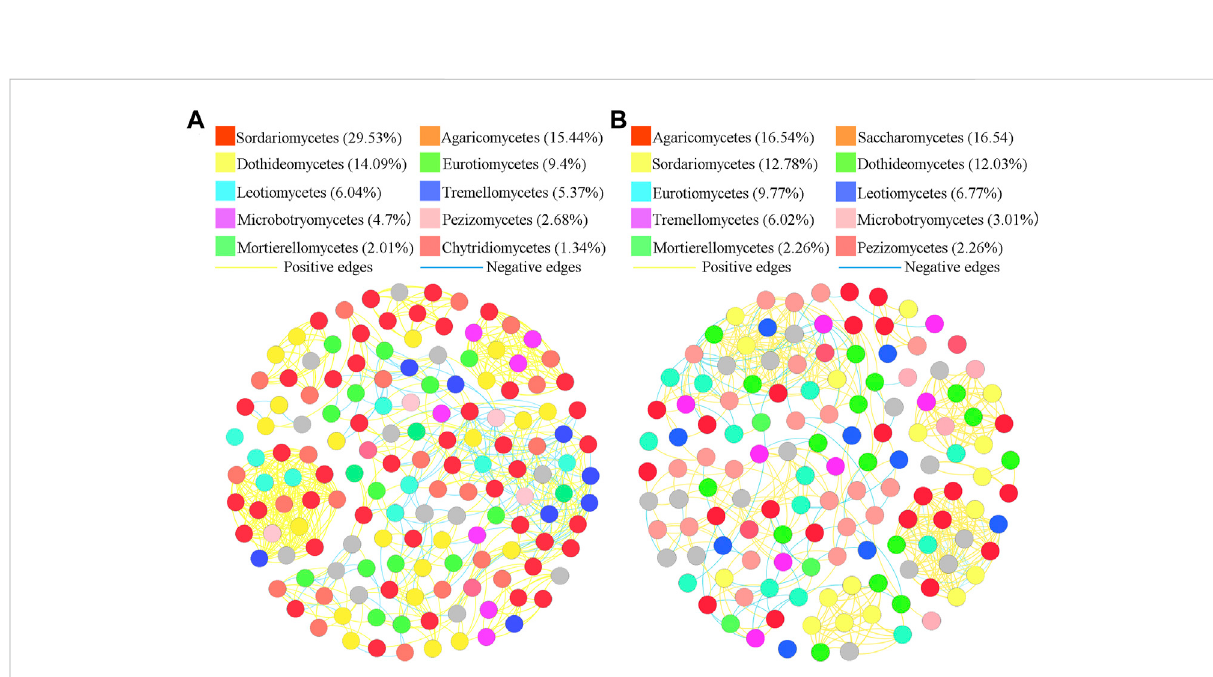
FIGURE 5 Schematic representation of symbiotic network patterns of soil fungi under different treatments at the genus level. These dots represented different genera of fungi that were clustered at class level. Different colors of the squares represent different dominant fungal genera that were clustered (only listthetop tenfungal classes).Yellowlinesbetween anyconnectedtwonodesindicatesapositive relationshipandbluelinesindicate a negative relationship (A) Schematic diagram of fungal community network in healthy rhizosphere soils. (B) Schematic diagram of fungal community network in diseased rhizosphere